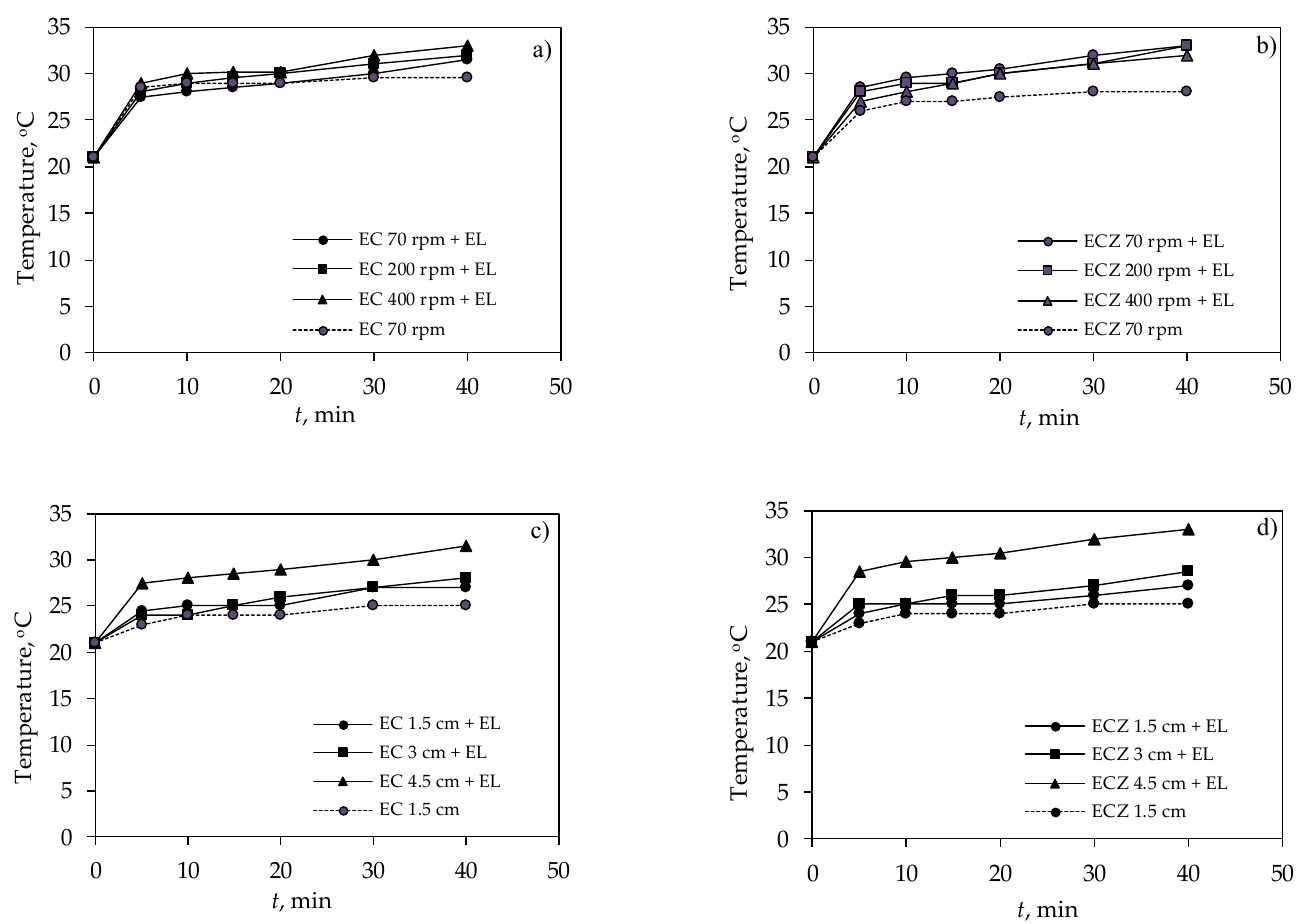
Figure 3. Change of temperature in solution during EC process at different: ( a ) stirring speed; ( b ) stirring speed with the addition of zeolite; ( c ) electrode distance; ( d ) electrode distance with addition of zeolite. Note: mark EL means the addition of electrolyte.